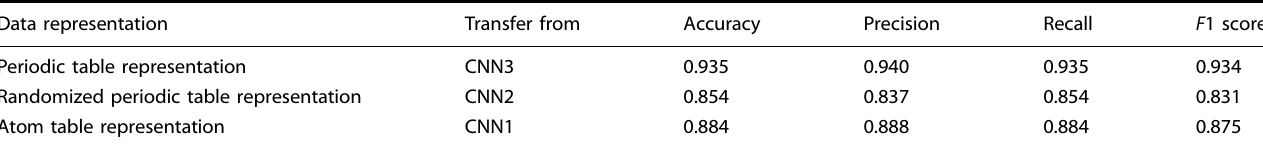
Table 3. The scores of transfer learning on high-entropy alloys dataset under fi vefold cross-validation with three data representations. Data